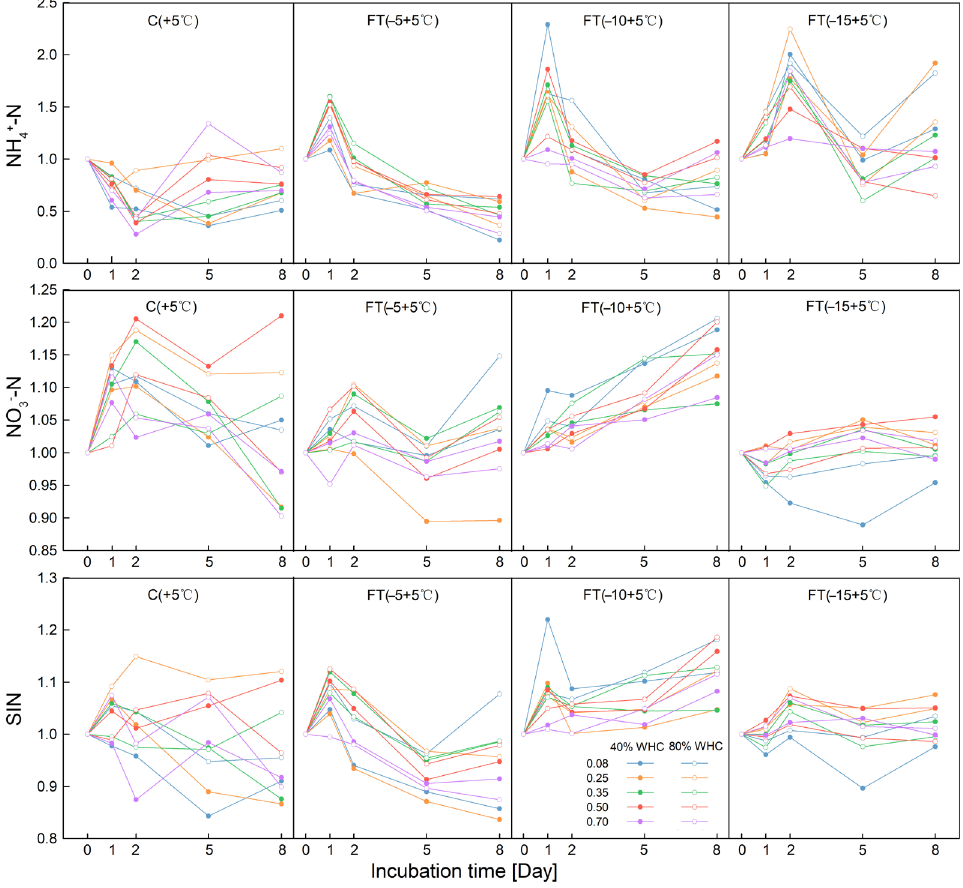
Figure A1. Ratio of soil NH 4+ -N, NO 3 − -N, and soil inorganic nitrogen (SIN) contents to their initial values during the incubation period under different salinity, freezing–thawing temperatures/cycles, and soil moisture content.